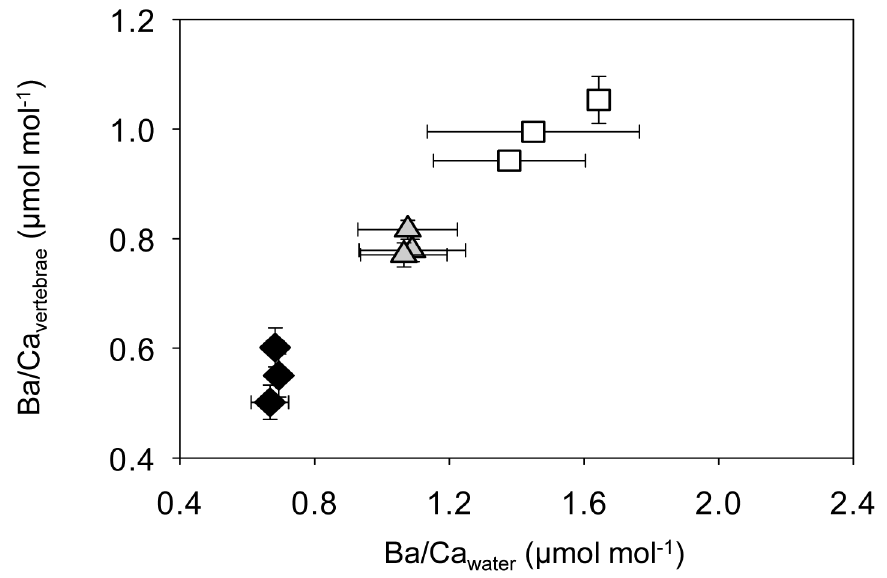
Figure 4. Relationships between water and vertebral barium to calcium ratios by barium treatment. Mean ± standard error of barium to calcium ratios for water and vertebral samples. Black diamonds represent 1x, grey triangles 3x, and unfilled squares 6x barium treatments. Element to calcium ratios were log -transformed. 10